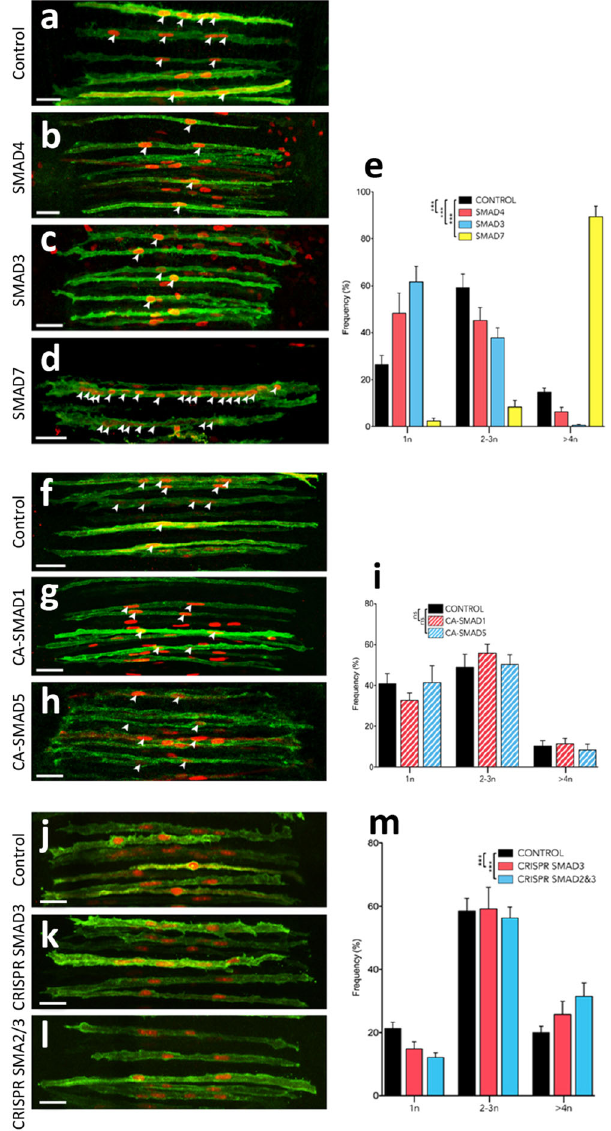
indicates a tendency to promote fusion. Solid colours in column graphs indicate signi fi cant differences with controls while striped patterns indicate non-signi fi cant results. compared to controls), while only few multinucleated fi bres were Fig. 3d, e; Supplementary Fig. 6). Nearly all fi bres had 4 or more